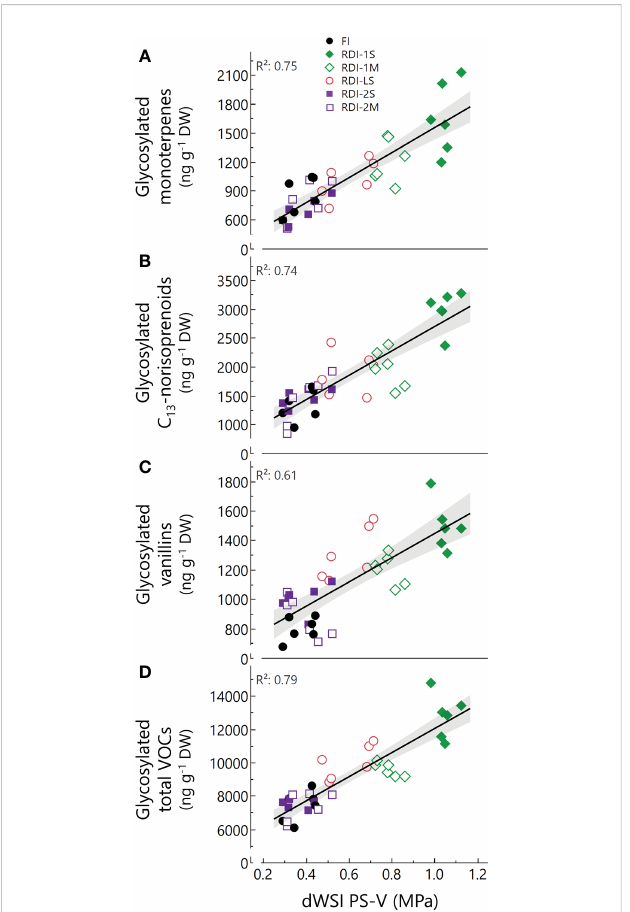
FIGURE 1 The relationship between total glycosylated monoterpenes, total glycosylated C 13 -norisoprenoids, total glycosylated vanillins, total glycosylated VOCs, and daily water stress integral (dWSI) from pea size (PS) to the beginning of veraison (V) in berries of Sangiovese ( Vitis vinifera L.) grapevines subjected to six different irrigation regimes (FI, full irrigation from berry pea size to harvest; RDI-1S and RDI-1M, severe and moderate water de fi cit applied from berry pea size to beginning of veraison; RDI-LS, water de fi cit applied during lag phase; RDI-2S and RDI-2M, severe and moderate water de fi cit applied from beginning of veraison to harvest) in 2019 and 2020. Equations: (A) y=257.4+1259x; (B) y=584.3+2111x; (C) y=622+822.6x; (D) y=4801 +7230x. Each symbol represents one replicate. Con fi dence interval (95%) in